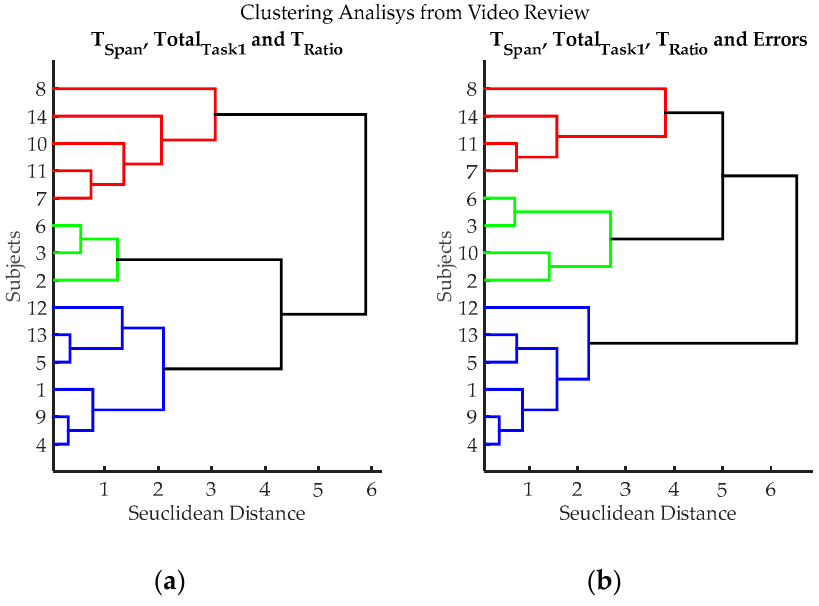
Figure 7. Clustering results according to the variables evaluated from video records of volunteers while executing exercise 3. ( a ) Clustering classification using variables: T Span , Total Task1, and T Ratio . Errors were not utilized in this classification process, to evaluate if it introduces subjective bias (Estimating the number of errors is dependent on the judgment of the evaluator); ( b ) Hierarchical classification using variables: variables T Span , Total Task1 , T Ratio , and Errors . Three groups can be clearly differentiated, blue (volunteers 1, 4, 5, 9, 12 and 13), red (volunteers 7, 8, 11 and 14) and green (volunteers 2, 3, 6 and 10); volunteer 10 can be considered either green or red. Table 2. Comparison of the level of dexterity found in each group. Each column represents the average and standard deviations for each variable in each group. The blue group has high dexterity, as they, in general, take shorter times, lower T Ratio values and made fewer errors. Conversely, the red group has lower dexterity, as they in general, take longer times, higher T Ratio values and made many errors. The green group has average dexterity.